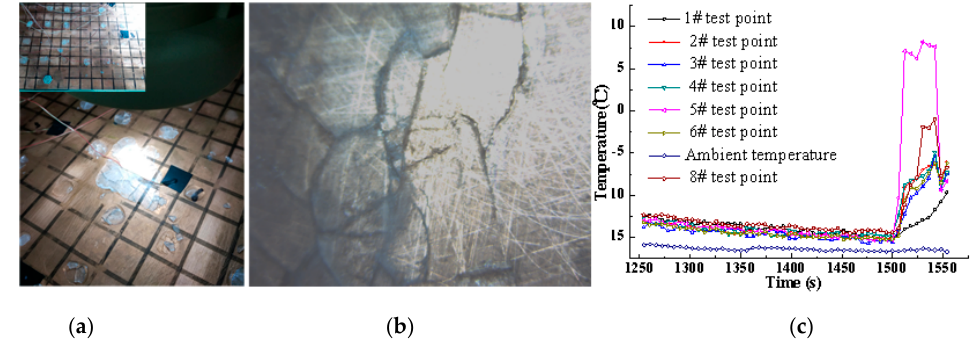
Figure 13. Basic frost layer removal and temperature variation of the copper plate with ultrasonic excitation. ( a ) Macro-frost layer removal; ( b ) micro-frost layer cracking; ( c ) temperature on copper plate.